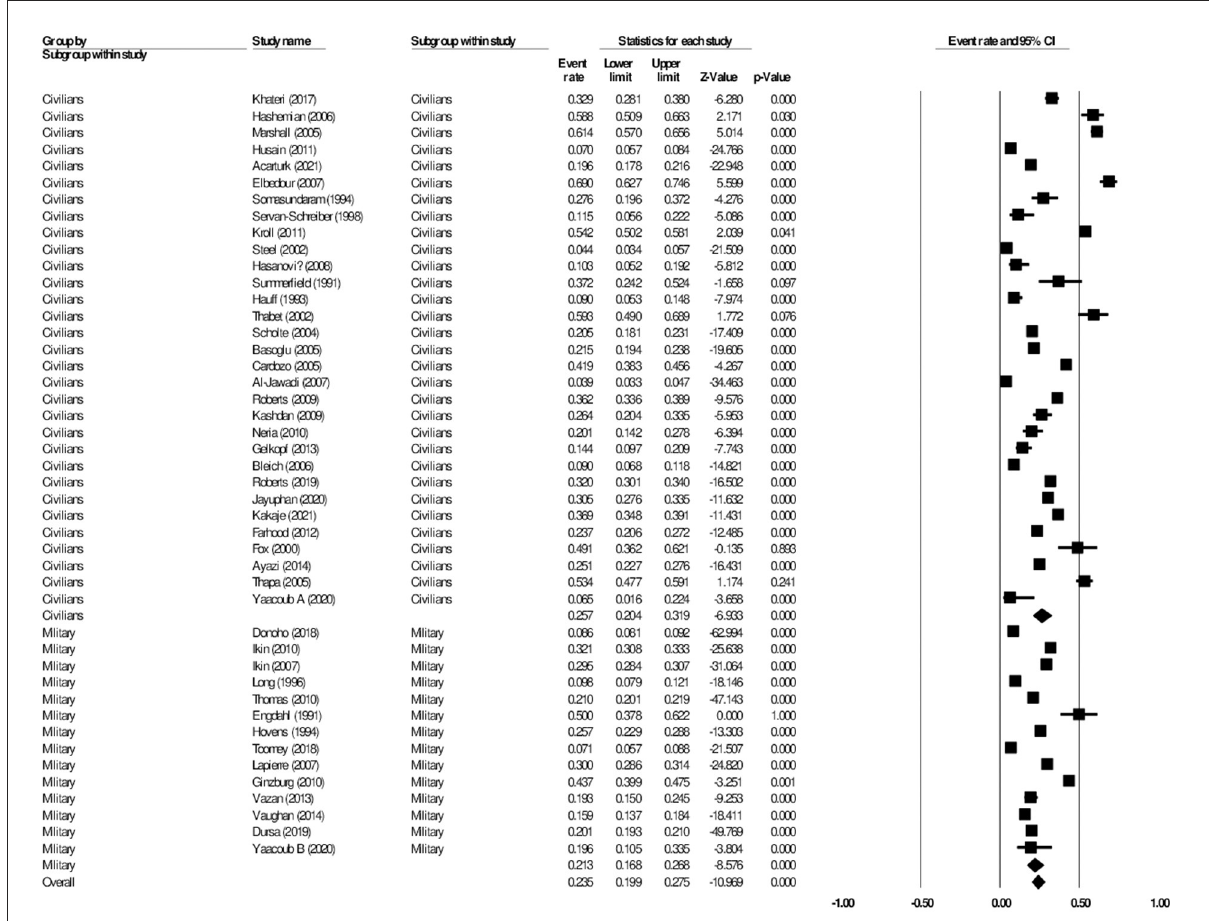
FIGURE6 Forest plot showing prevalence of post-traumatic stress disorder, including analysis between military and civilian